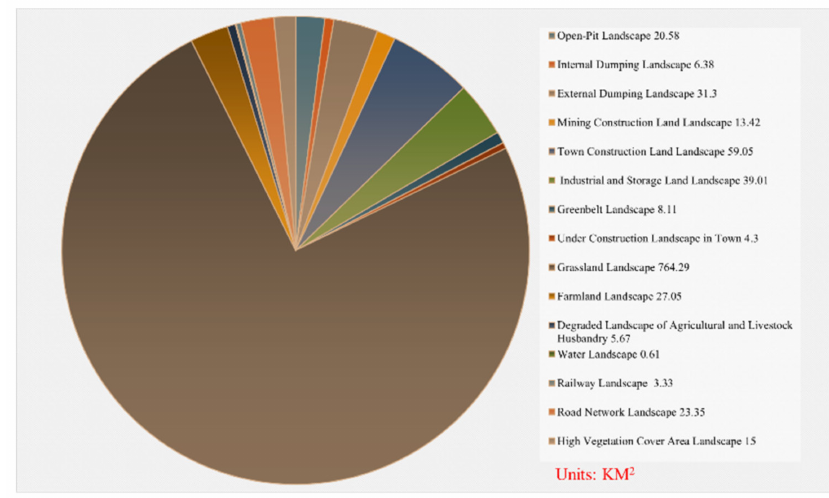
Figure 8. The area of various landscapes.